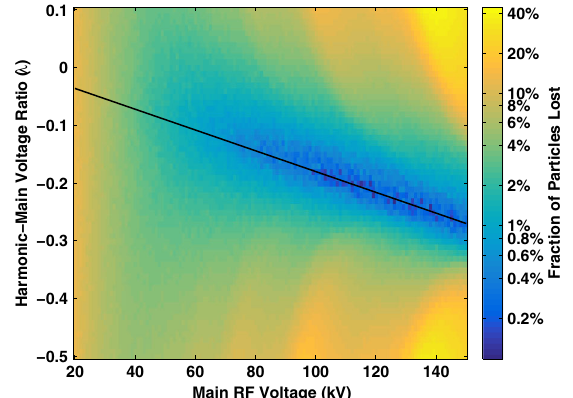
FIG. 15. Particle loss as a function of Recycler main rf voltage and λ .